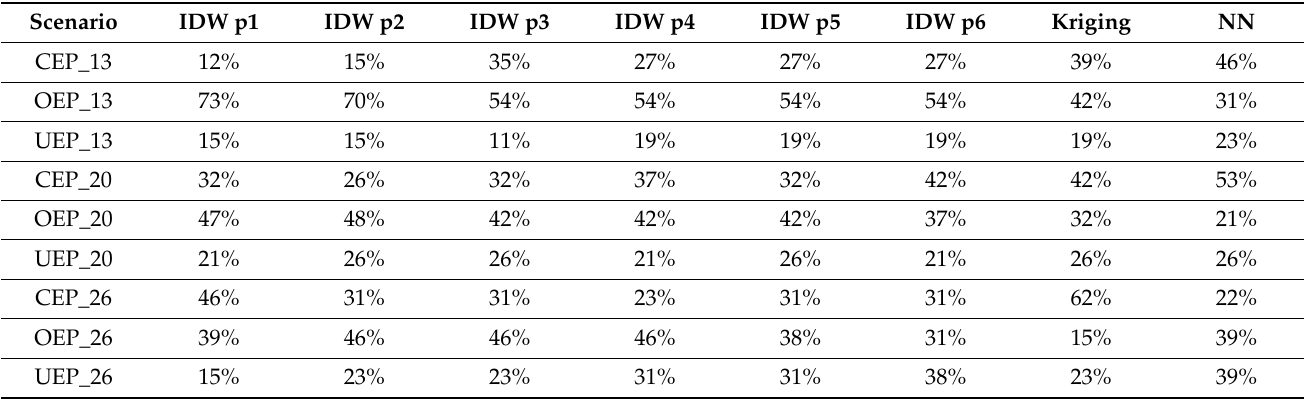
Table 6. The comparison of the ratio of Correct Estimation Points (CEPs), Overestimation Points (OEPs), and Underestima- tion Points (UEPs) for selected interpolation methods and lowest RMSE tests.